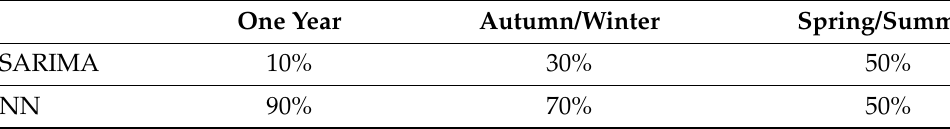
Table 7. Percentage of component for each training period.